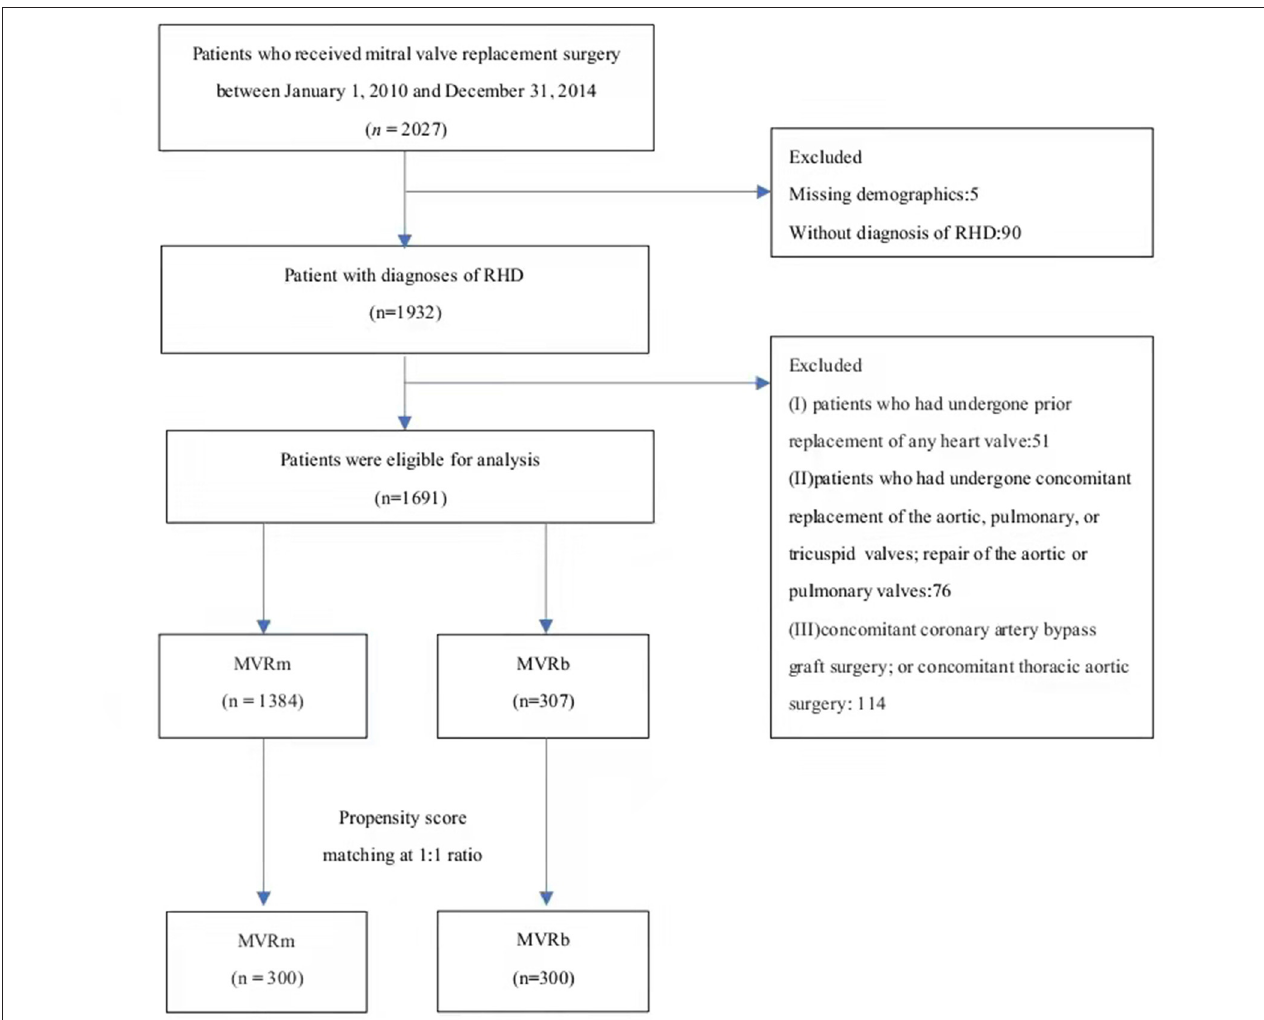
FIGURE 1 | The flowchart of patient inclusion and exclusion. RHD, Rheumatic heart disease. MVRm, mechanical mitral valve replacement; MVRb, bioprosthetic mitral valve replacement.